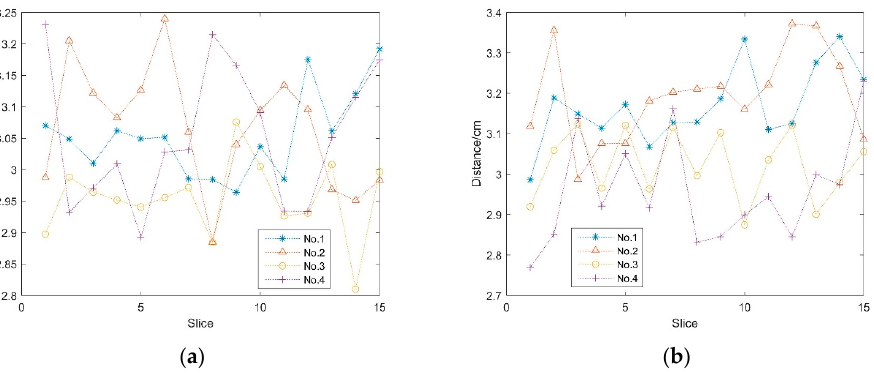
Figure 9. Spot spacing measured with ( a ) MAGAT-f gel and ( b ) PAGAT gel at different depths (slice thickness was 3 mm). thickness was 3